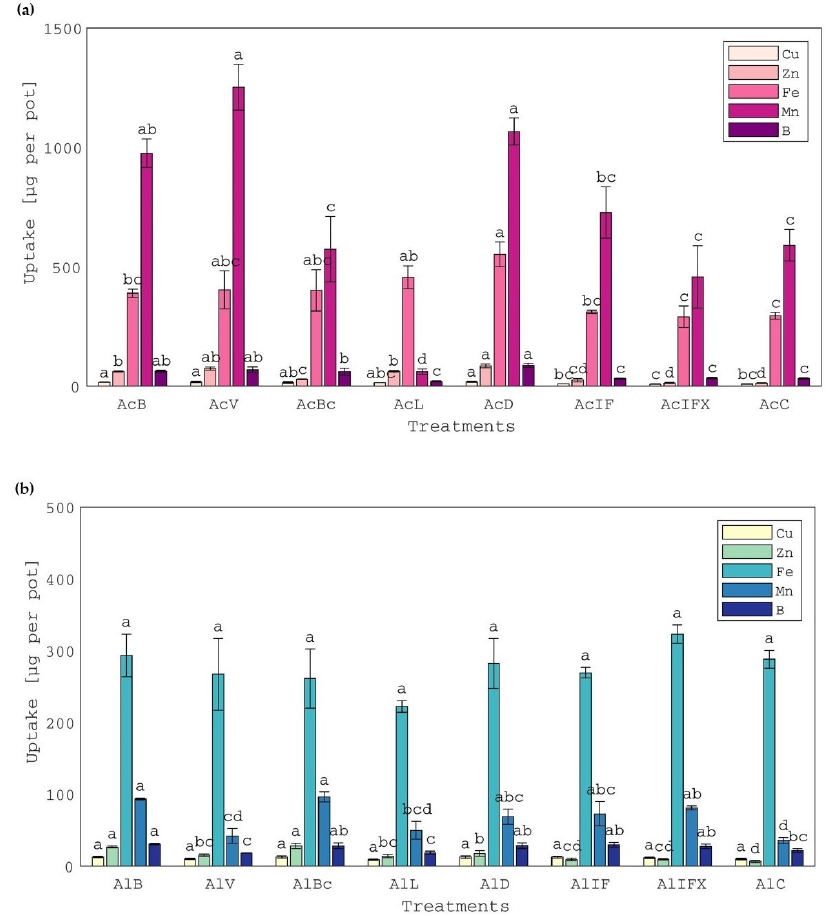
Figure 3. Uptake of micronutrients by white clover plants, grown in ( a ) acid soil treatments and ( b ) alkaline soil treatments. Treatment of the acid and alkaline soil, respectively, with: AcB and AlB: bentonite-treated sludge; AcV and AlV: vermiculite-treated sludge; AcBc and AlBc: biochar-treated sludge; AcL and AlL: limed sludge; AcD and AlD: air-dried sludge; AcIF and AlIF: N-P-K inorganic fertilization; AcIFX and AlIFX: P-K inorganic fertilization; AcC and AlC: control. Different letters, within each soil and property, indicate significant differences among means, using the LSD test, at p ≤ 0.05.